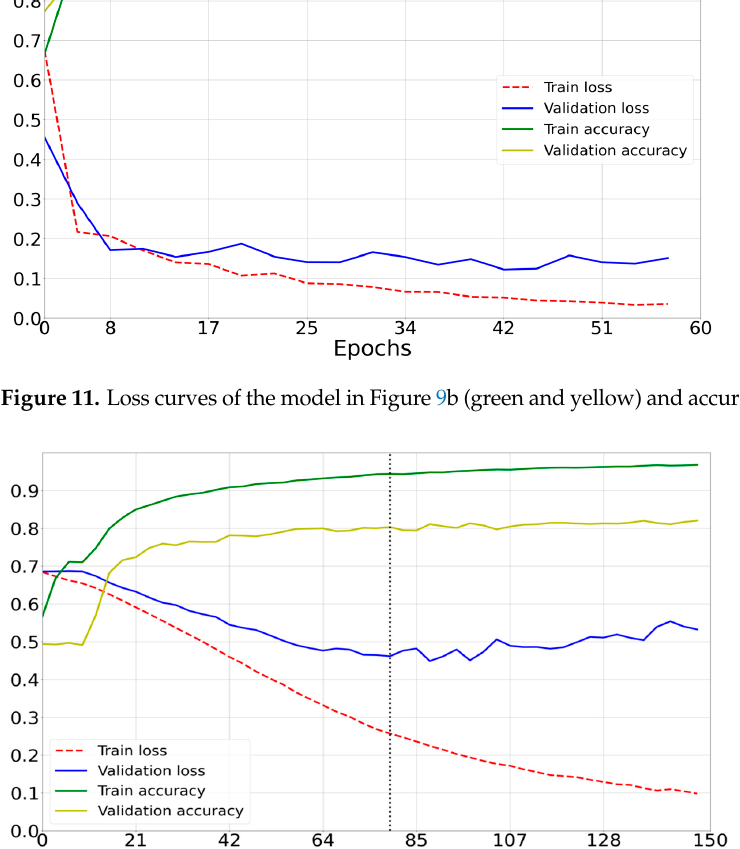
Figure 12. Loss curves of the model (Figure 9c) (green and yellow) and accuracy curves (blue and red). -